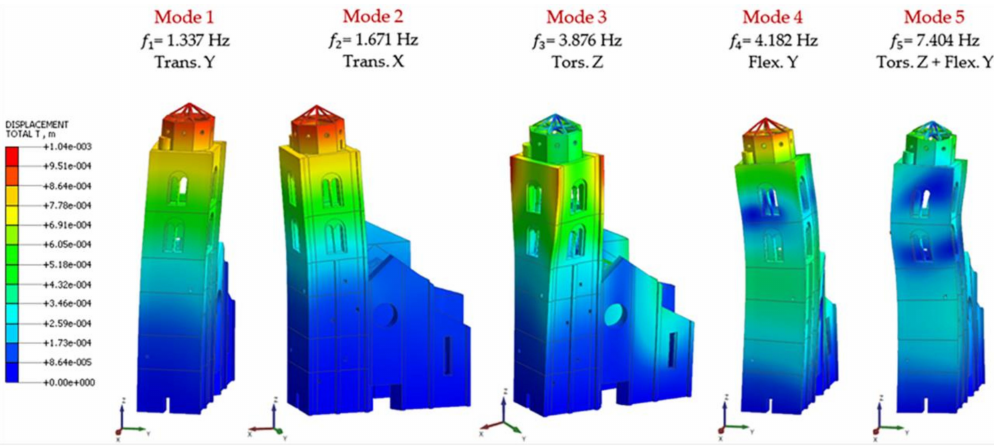
Figure 7. Numerical Model: mode shapes and frequencies at step